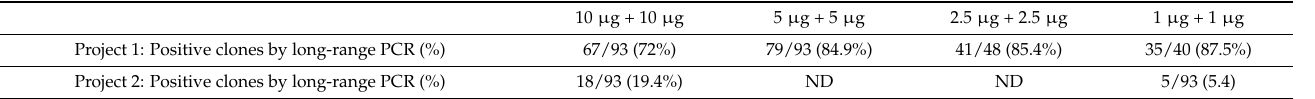
Table 2. Quantity of circular targeting construct and circular CRISPR construct.